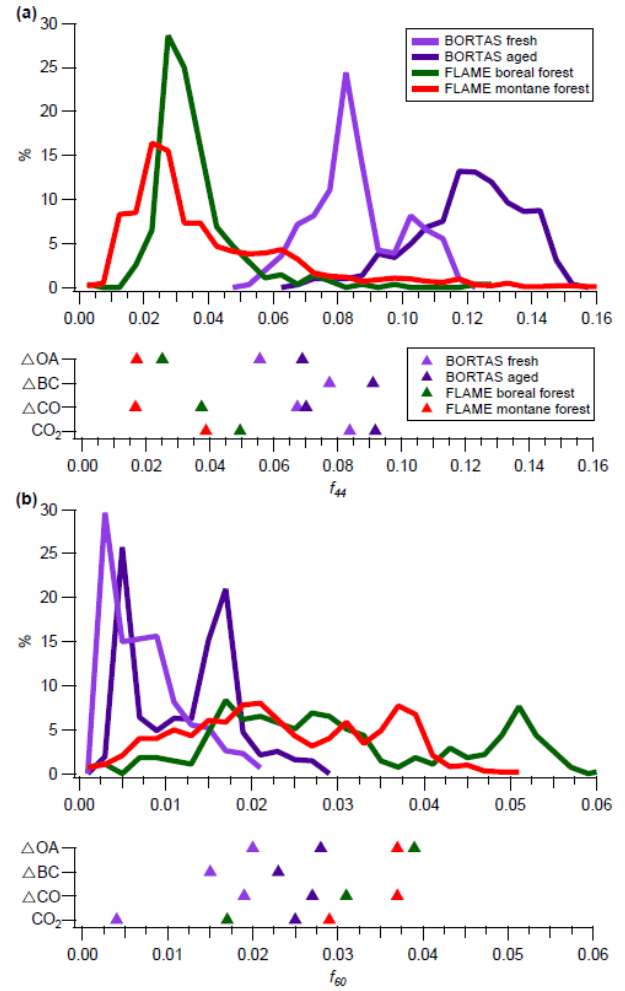
Figure 10. Probability density functions for (a) f 44 and (b) f 60 from a range of ambient and laboratory BB measurements. Also shown in the lower sections of each panel are the f 44 and f 60 values corresponding to maximum concentrations of (cid:49) OA, (cid:49) BC, (cid:49) CO and CO 2 ( (cid:49) CO 2 during